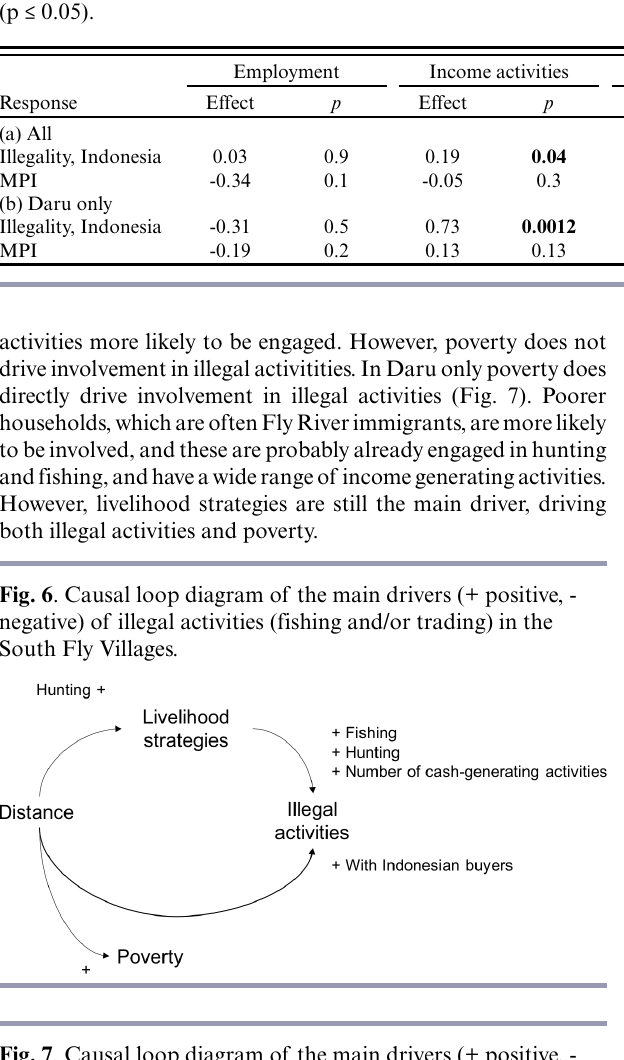
Fig. 7 . Causal loop diagram of the main drivers (+ positive, - negative) of illegal activities (fishing and/or trading) in